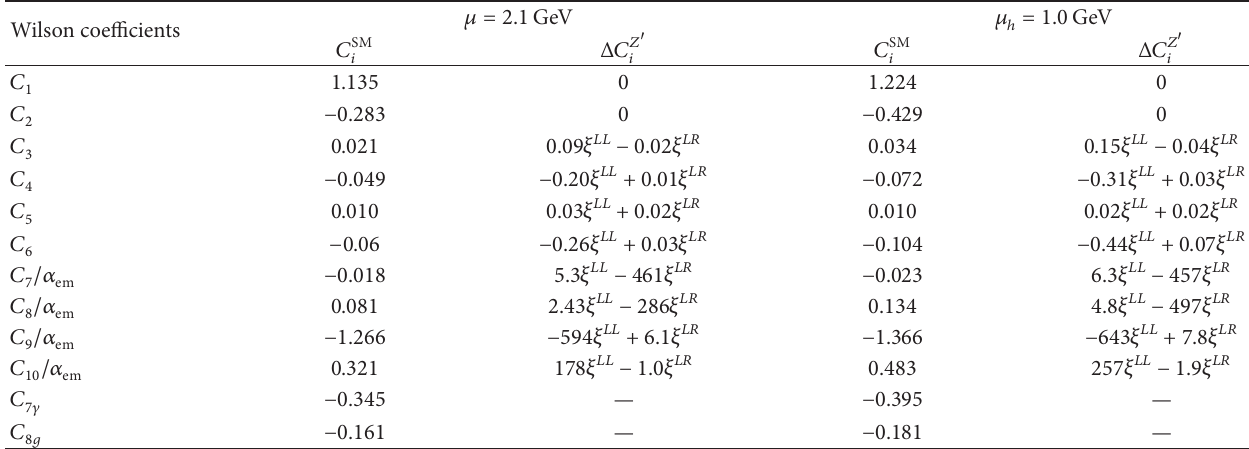
Table 3: The Wilson coefficients 𝐶 𝑖 within SM and with the contribution from 𝑍 󸀠 boson included in NDR scheme at the scale 𝜇 = 2.1 GeV and 𝜇 ℎ = 1.0